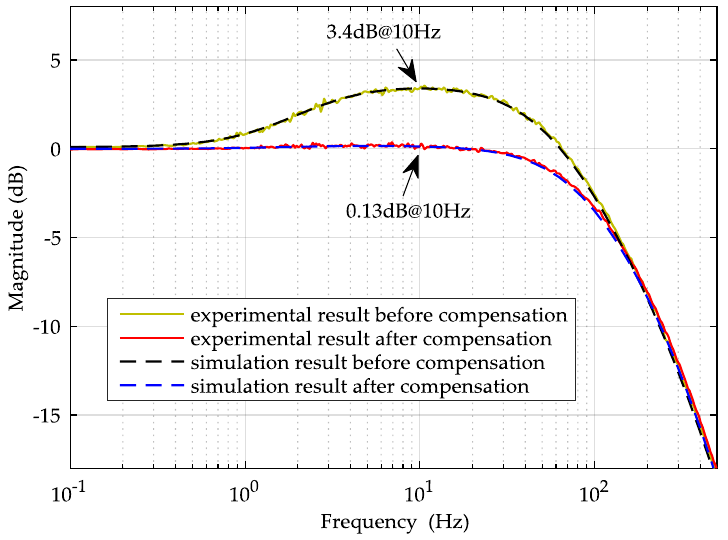
Figure 8. Simulated and experimental results of the x-axis closed-loop frequency responses.